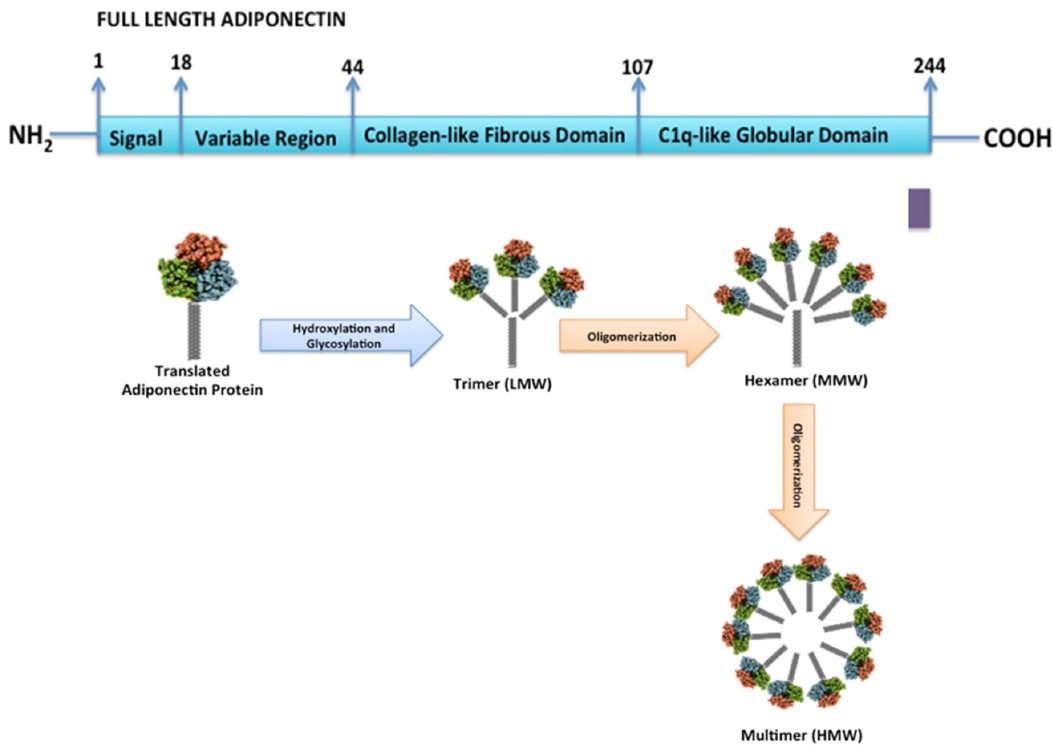
Figure 1. Domains and structure of adiponectin. The primary structure of adiponectin, which consist of 244 amino acids, has an N-terminal signal sequence, a variable region with attached O-glycoside side chains, a collagenous domain, and a C-terminal sequence of a globular domain. 2.3. Different Physiological Roles of the Adiponectin Binding Receptors of AdipoR1, AdipoR2, and T- Cadherin